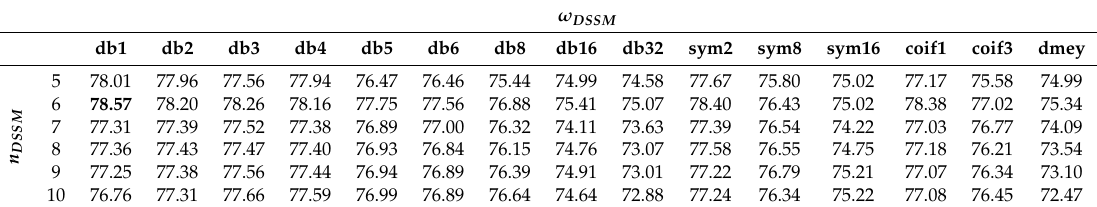
Table 10. The accuracy (%) of six class sleep stage classification with different wavelet bases and different order of DSSM under R&K standard. Only DSSMFs are used, no LEFs.